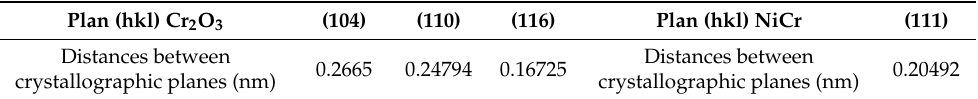
Table 6. Reference distance for the free of stress diffraction peaks.